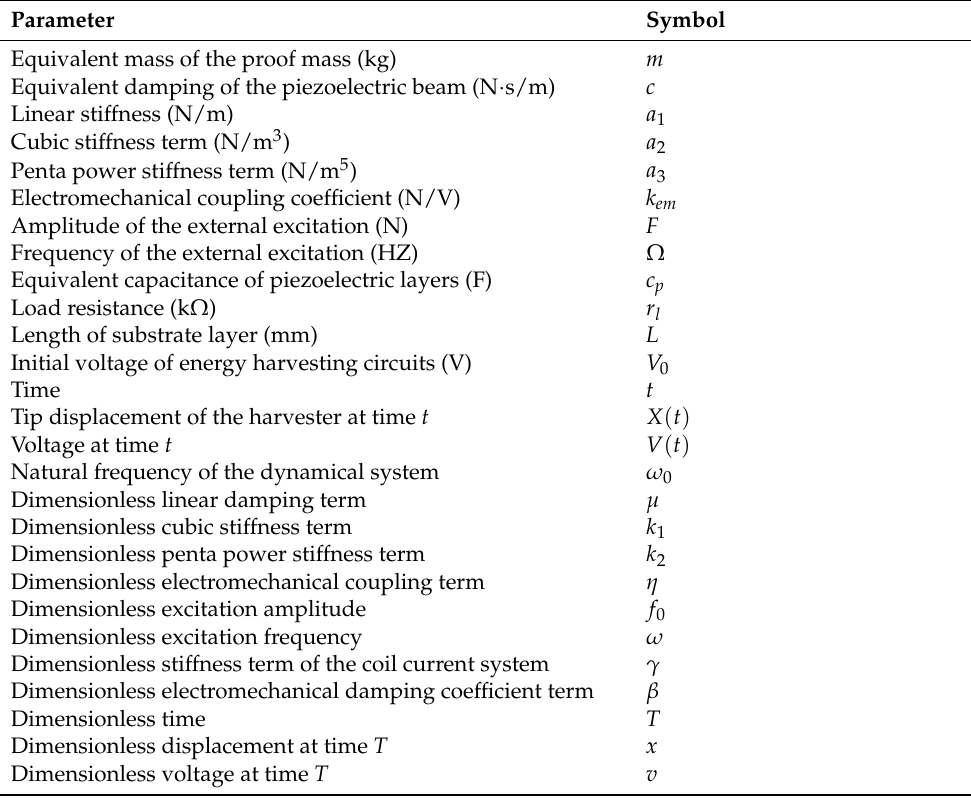
Table 1. Parameters of systems (1) and